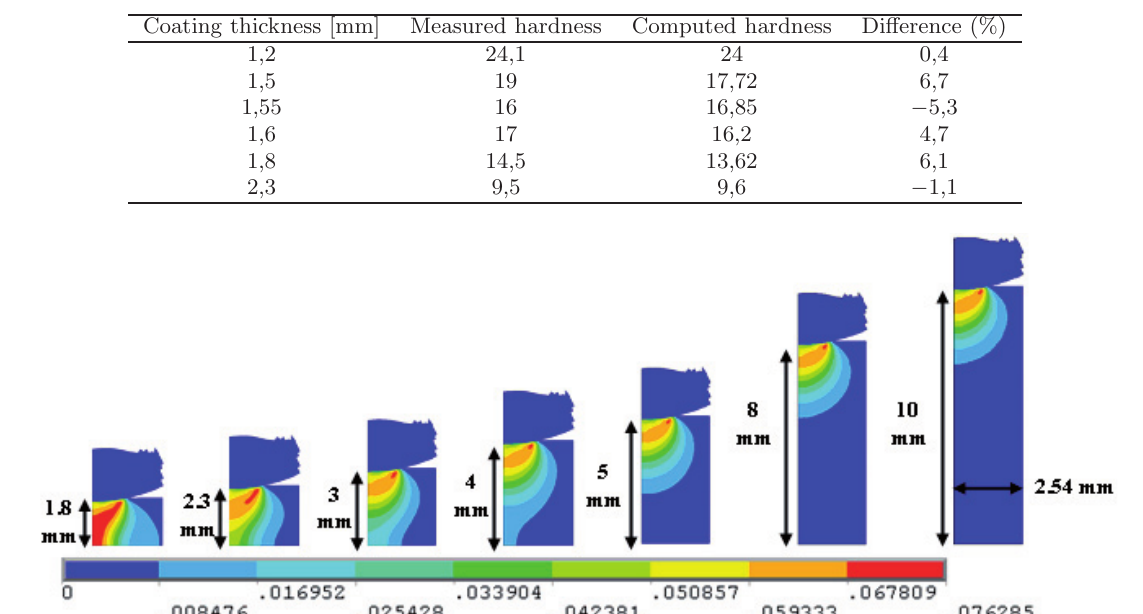
Table 1. Comparison between measured and computed hardness.